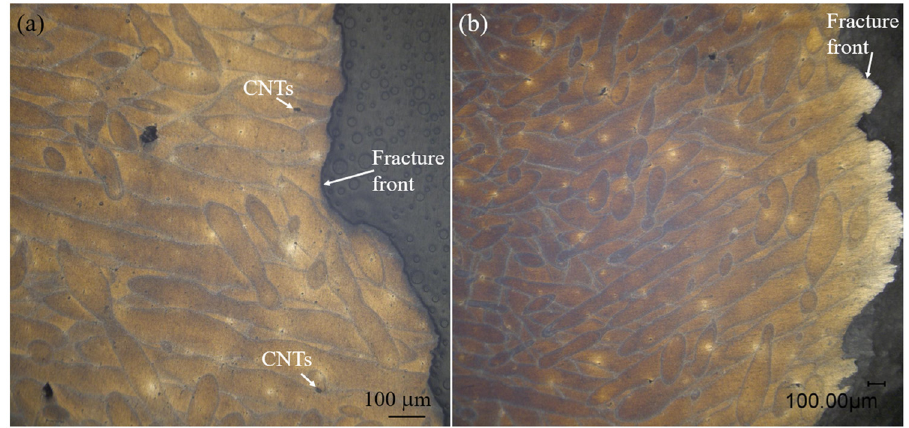
Figure 7: Crack front melt pool morphology of the tensile test specimen showing ( a ) the crack propagation path deviations triggered by melt pool boundaries and ( b ) an elongated melt pool